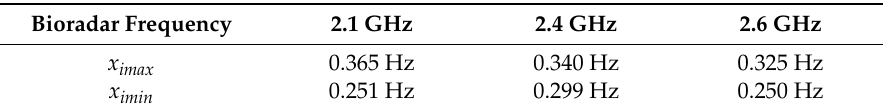
Table 3. x imax and x imin values of bioradar system.